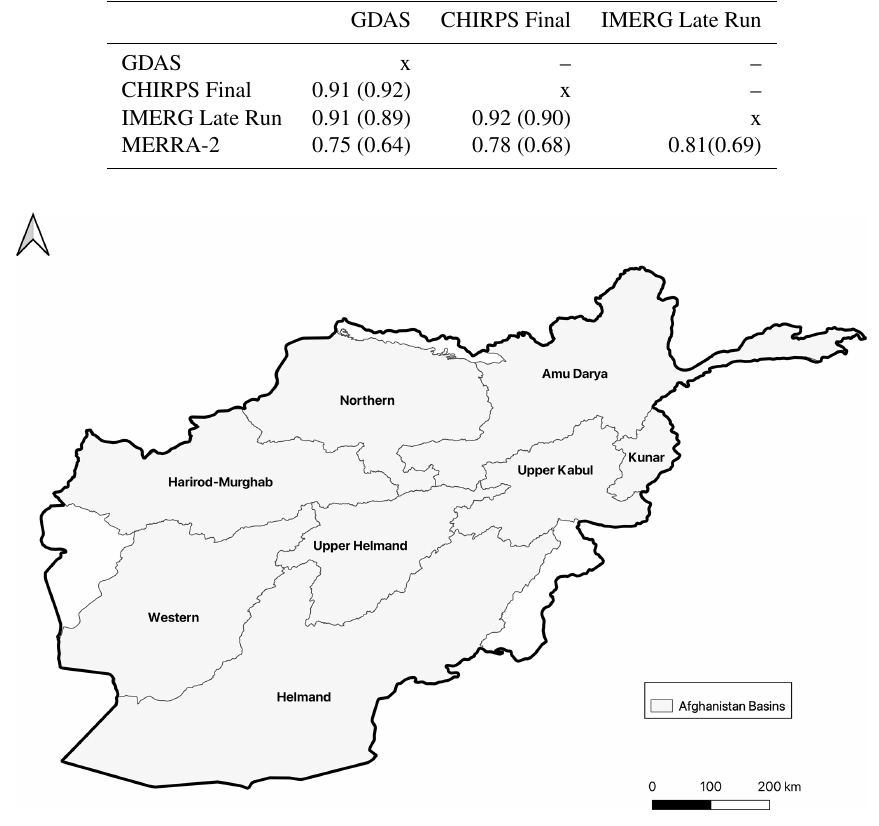
Figure 5. Hydrologic basins used in the analysis of categorical statistics for snow-covered fraction.